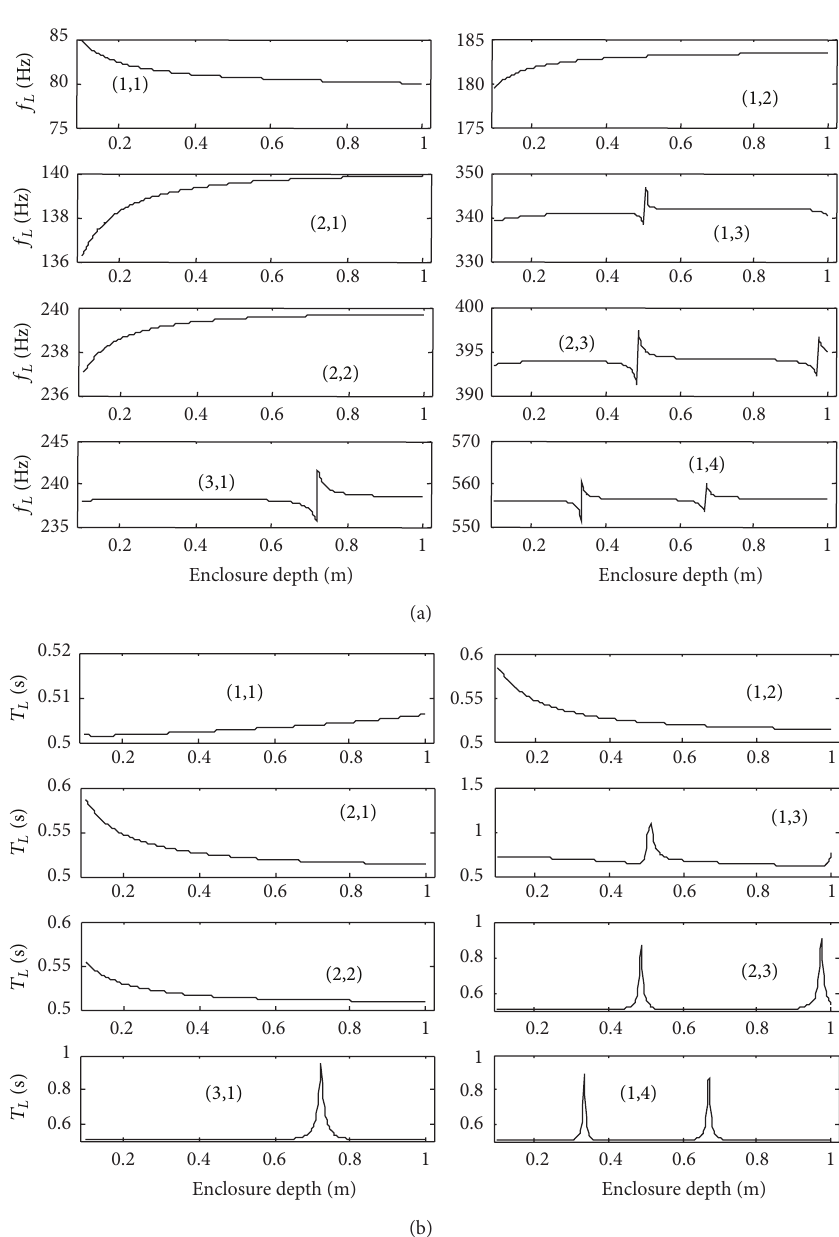
Figure 9: Resonance frequencies and decay times of the first few panel-controlled modes as a function of enclosure depth: (a) resonance frequency, (b) decay time. ℎ = 0.007 m, 𝑇 𝑎𝑁 = 15 s, 𝑇 𝑝𝑀 = 0.5 s. gradually as the enclosure depth is increased. On the contrary, the resonance frequency of the (1,1) panel-controlled mode is reduced. This is because of that the resonance frequencies of the (1,1) uncoupled panel mode are larger than the (0,0,0) rigid wall enclosure mode, while the resonance frequencies of panel modes (1,2), (2,1), (2,2) is less than those of enclosure modes. The resonance frequencies of panel-controlled modes (1,3), (2,3), (3,1), and (1,4) appear jump phenomenon in the process of the change of enclosure depth, which